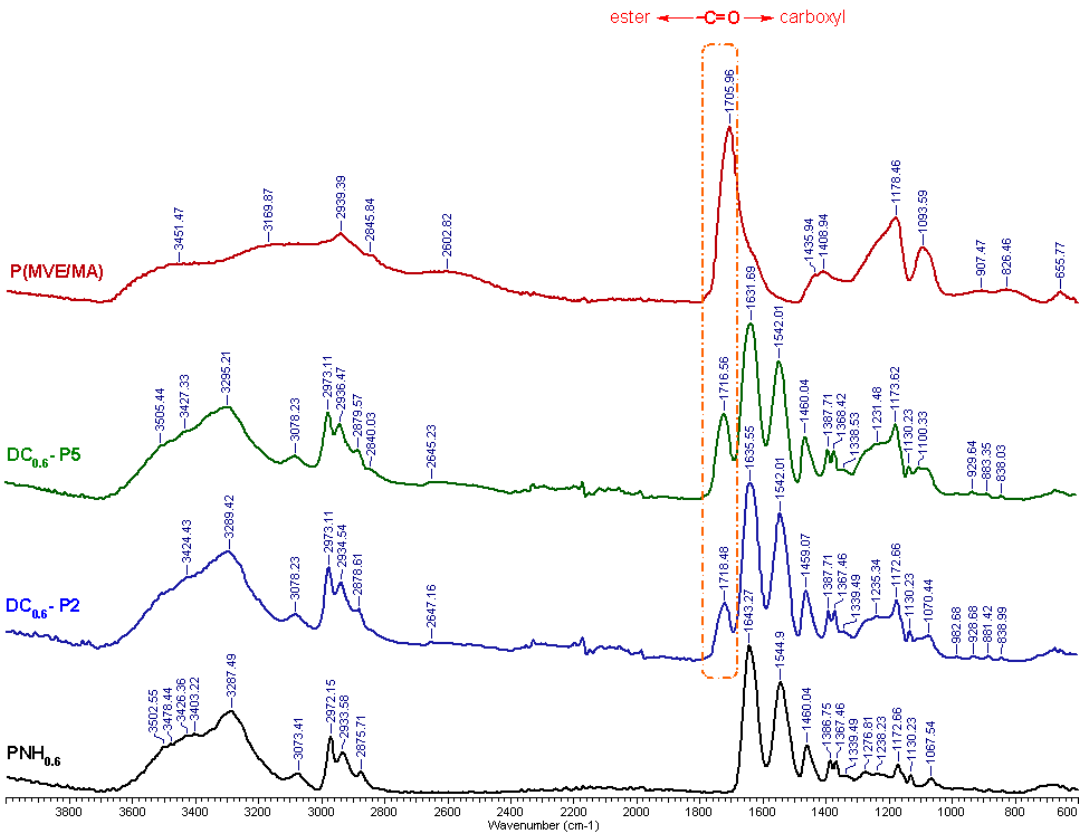
Figure 3. FT-IR spectra of the conventional (PNH 0.6 ) and double cross-linked hydrogels (DC 0.6 –P2 and DC 0.6 –P5). For comparison the spectrum of P(MVE/MA) is depicted.